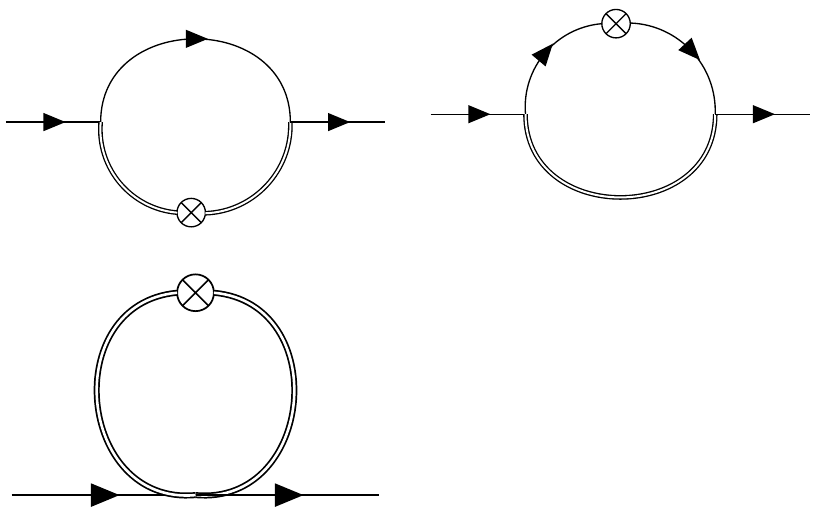
Figure A1. Feynman diagrams encoding the contributions (A28) to the RG flow. Solid and double internal lines correspond to the fermion and gravity propagators while the crossed circle marks the insertion of the corresponding regulator. The external straight lines denote background fermionic fields. The explicit expressions for the vertices are collected in Appendix